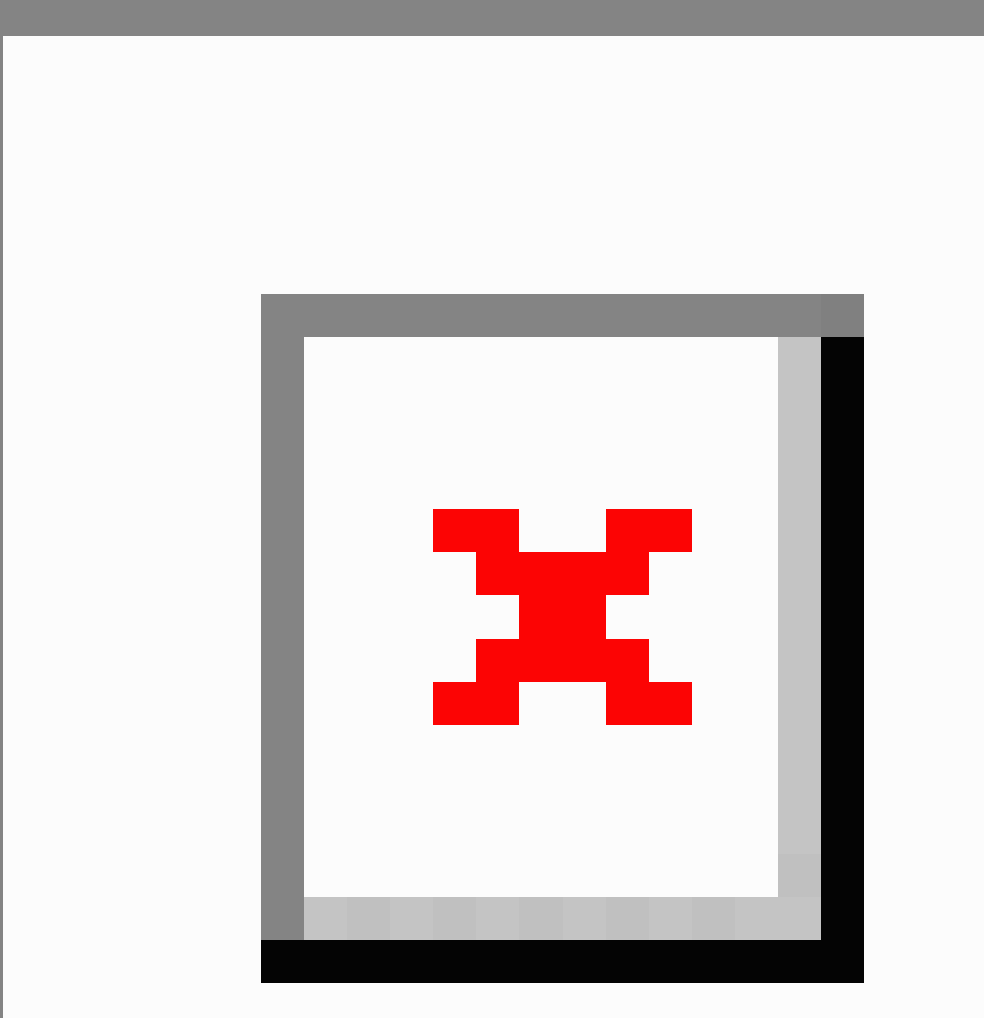
Figure 3. Screenshot of an ePOCS system questionnaire item (item 7 from the 21-item Social Difficulties